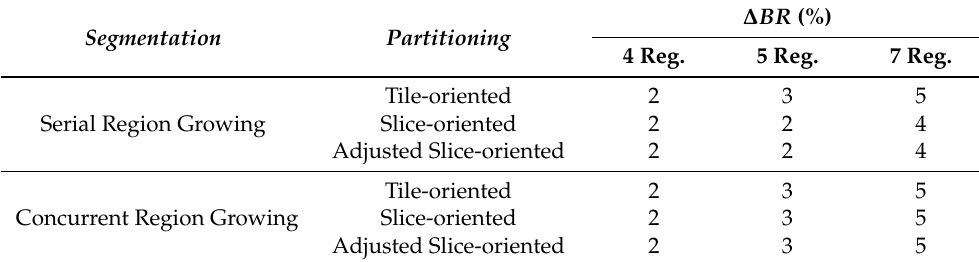
Table 8. Bitrate difference between proposed algorithm and baseline VVC